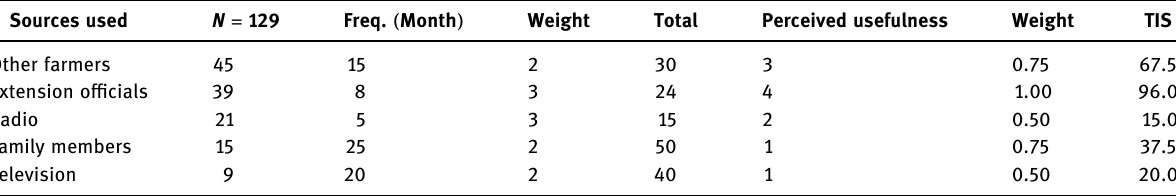
Table 4: TISs of respondents